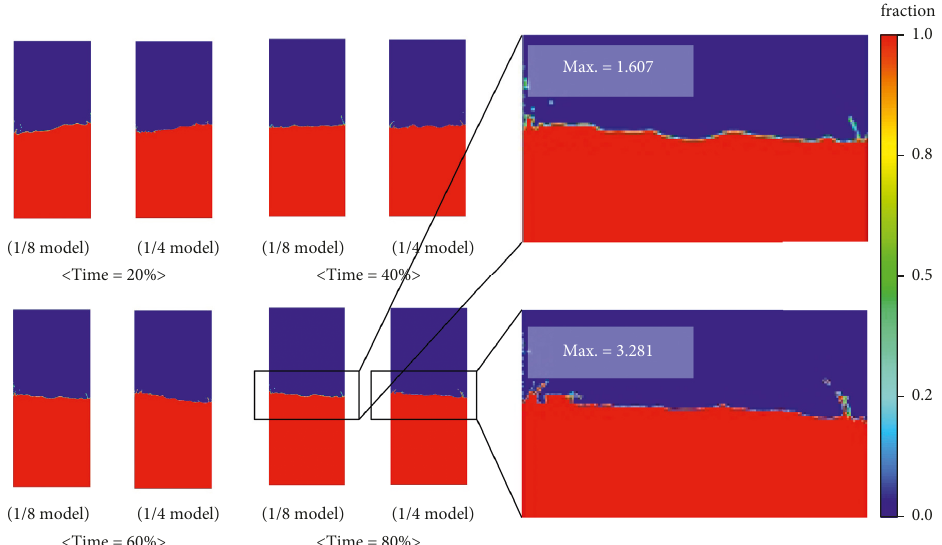
Figure 8: Differences in sloshing height caused by